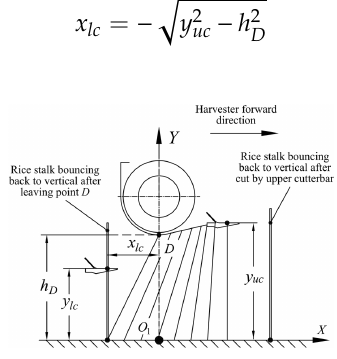
Figure 4. Stalk deformation before cut by lower cutterbar. h D is the height of the header frame lowest point, mm; x lc , y lc are the horizontal and vertical coordinates of the lower cutterbar blade midpoint, mm, respectively.